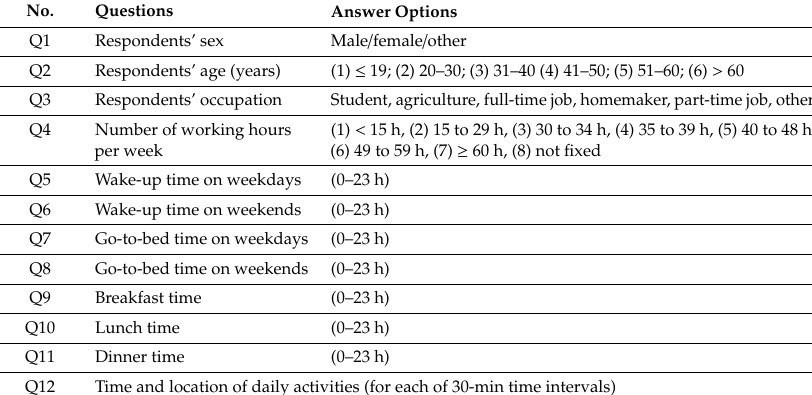
Table 6. Questionnaire items of the surveys.